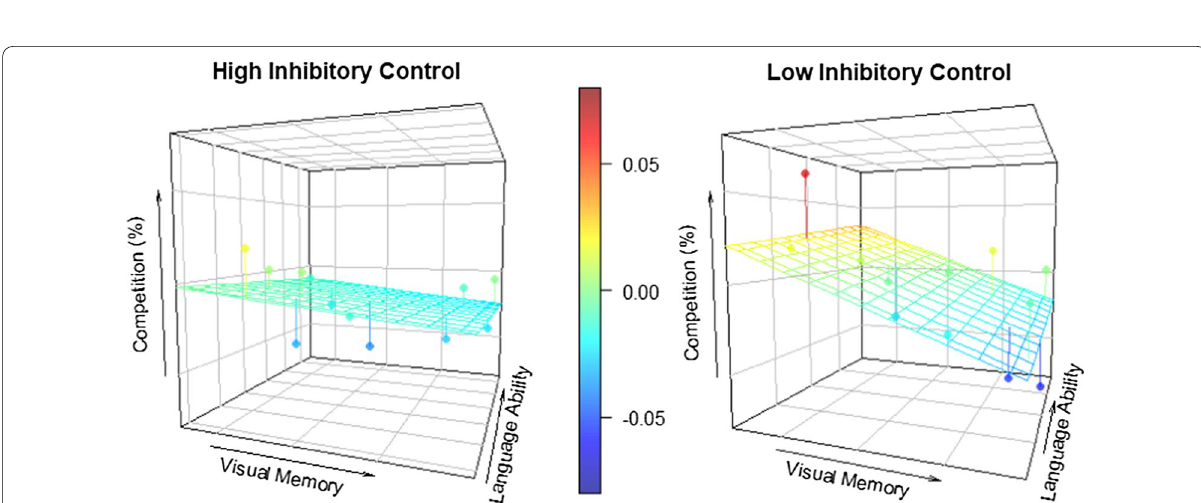
Fig. 6 Observed (dots) and predicted (grid) phonological competition (competitor—control fixation proportion) by visual memory and language ability for children with high (left) or low (right) inhibitory control. Redder shades indicate greater competition. Lower visual memory was associated with greater competition, especially for children with lower inhibitory